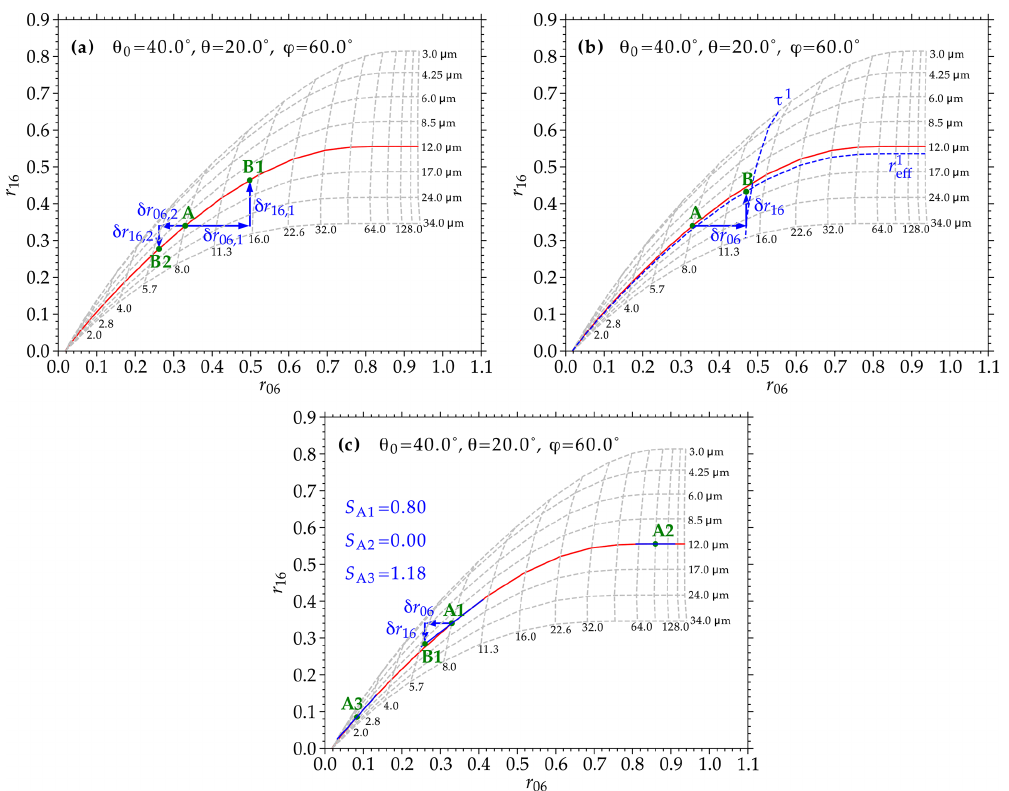
Figure 4. (a) Example SEVIRI lookup table for liquid-phase clouds, illustrating the lookup table approach (introduced in Sect. 4.3) for an observation highlighted by the reflectance pair indicated by point A. For two different high-frequency variations of the channel 1 reflectance ( δr 06 , 1 and δr 06 , 2 ) the derived high-frequency variations of the channel 3 reflectance ( δr 16 , 1 and δr 16 , 2 ) are shown. See text for more description. (b) Same as (a) but illustrating the adjusted lookup table approach (introduced in Sect. 4.4) with the adiabatic adjustment for a single δr 06 example. (c) Same as (b) but with the LUT slope